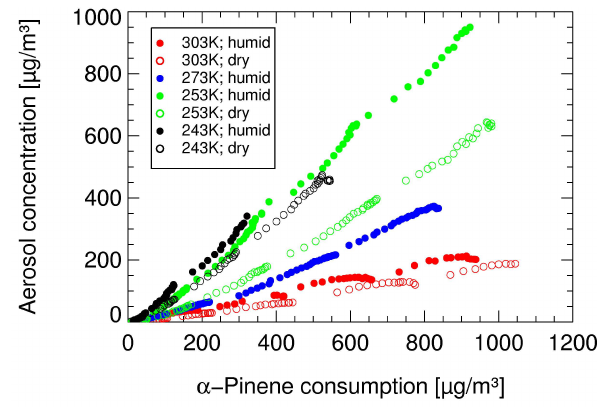
Fig. 2. Typical experiment performed in a sequence of single ad- ditions of α -pinene and ozone to the chamber. The experiment was conducted at dry conditions, a temperature of 303K and with 500ppm cyclohexane added as OH-scavenger. Data were analysed for the whole experiment in order to get average quantities for the given temperature and the humidity. Data were analysed for each section in order to get gas-phase yields and partitioning as a func- tion of the particle mass load.